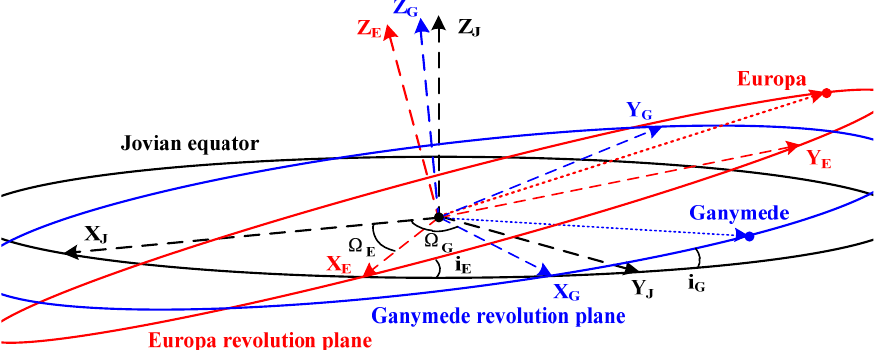
Figure 1. The definition of coordinate systems for a Europa